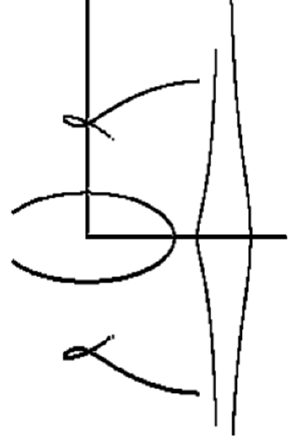
Figure 20. q = − 0.5, KG = 120, and DK = 120.